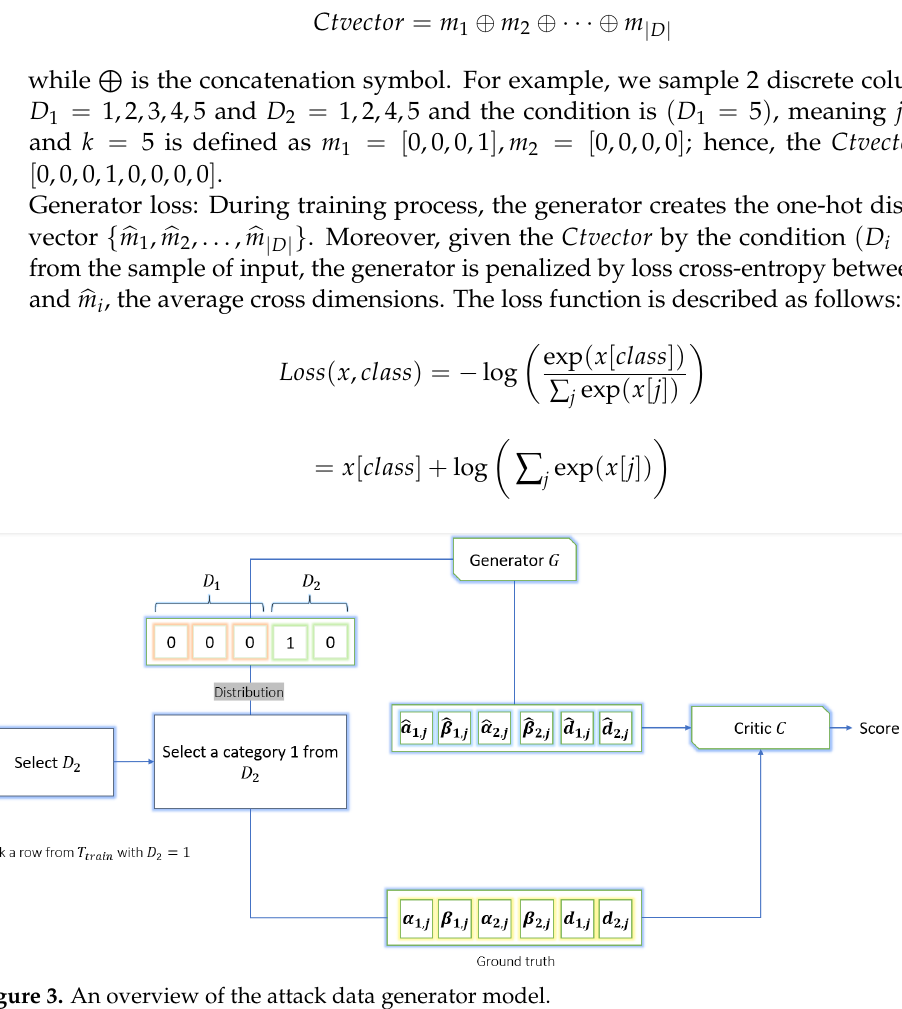
Figure 3. An overview of the attack data generator